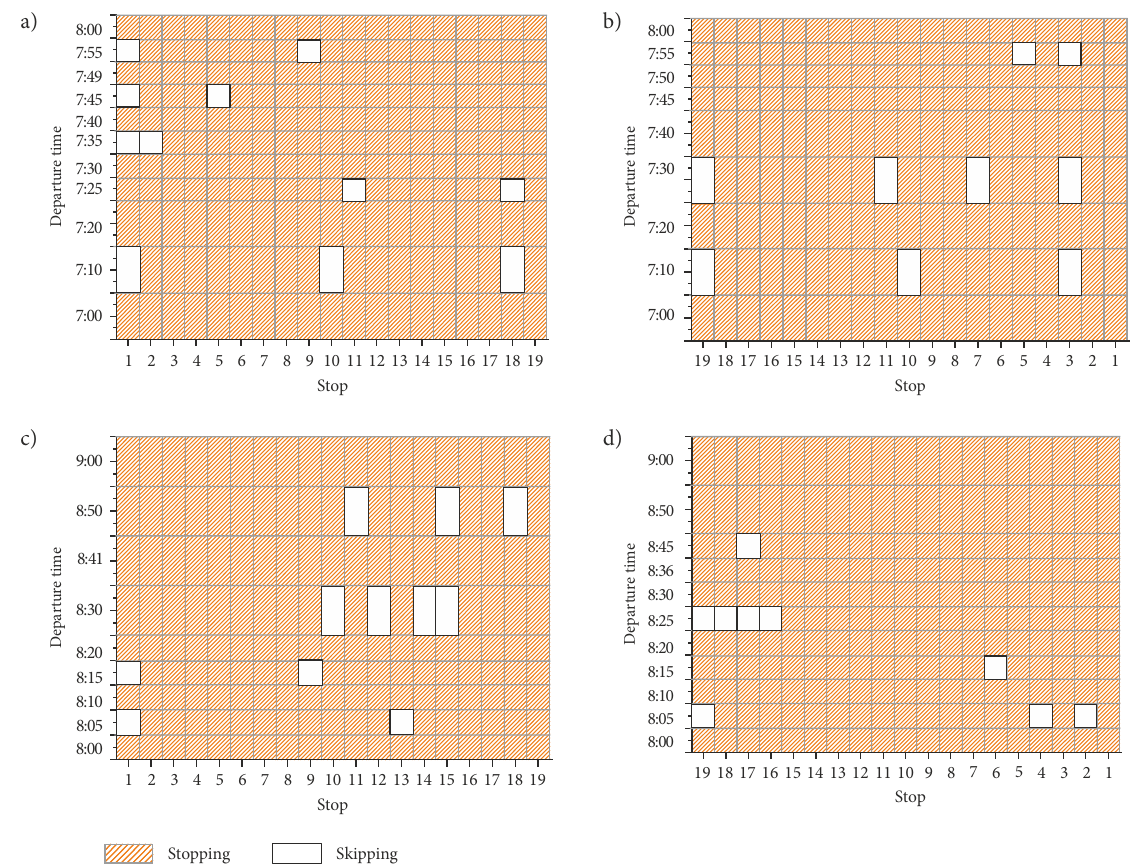
–4.55%Figure 6. Optimal results with bus trips operating FRO, short turn, limited stop, and mixed strategies: a – 7:00…8:00 in direction